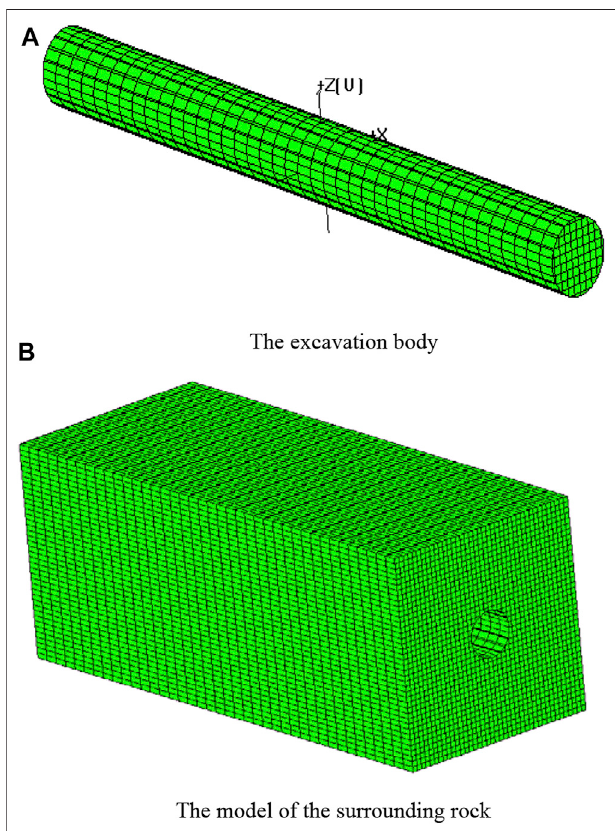
FIGURE 12 | Rock mass model of tunnel engineering. (A) The excavation body. (B) The model of the surrounding rock.